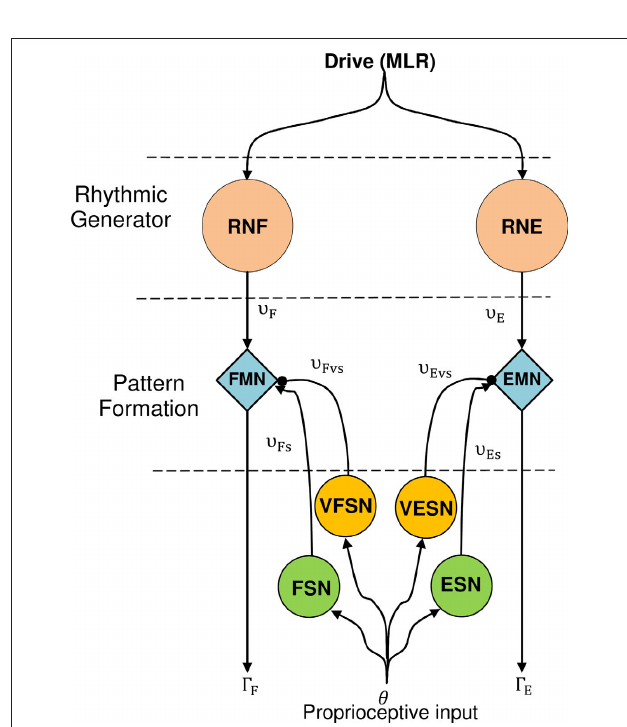
FiguRe 3 | Bifurcation diagram for values of σ Dmp, damped oscillating; Plt, plateau potentials; Osc, oscillating. τ = 0.05 s, A = 2. τ m f